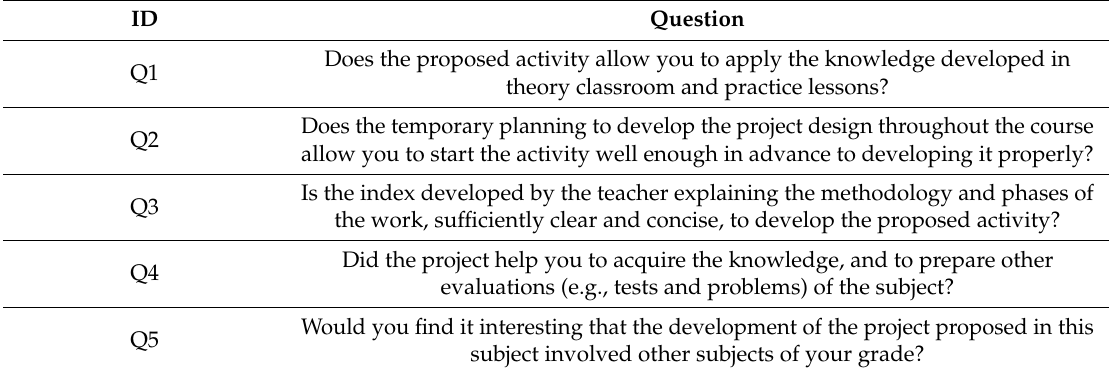
Table 3. Questions related to